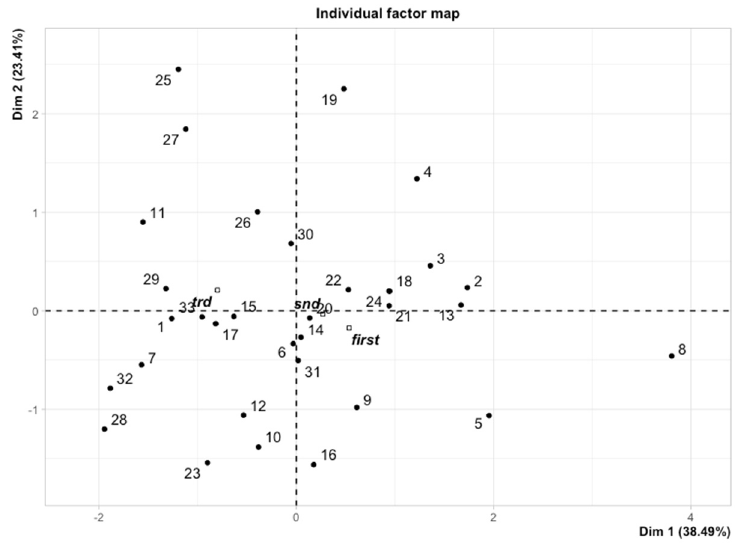
Figure 3. Individual factor map showing the position of each patient in the dimension 1 and 2 ma- trix.